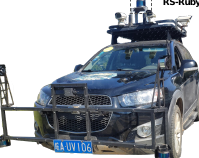
Figure 7. Autonomous driving experimental platform: “Intelligent Pioneer No. 3”.